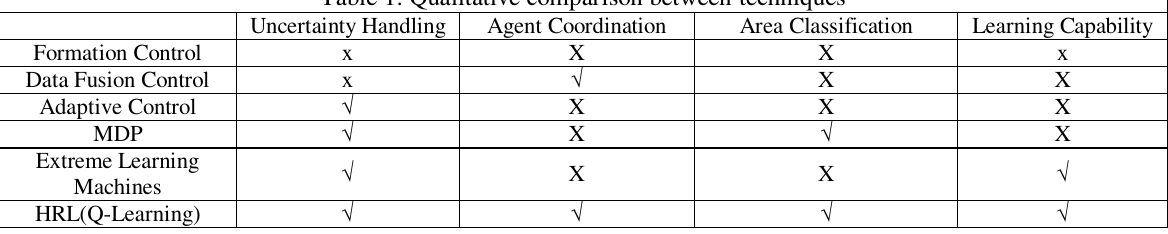
Table 1: Qualitative comparison between